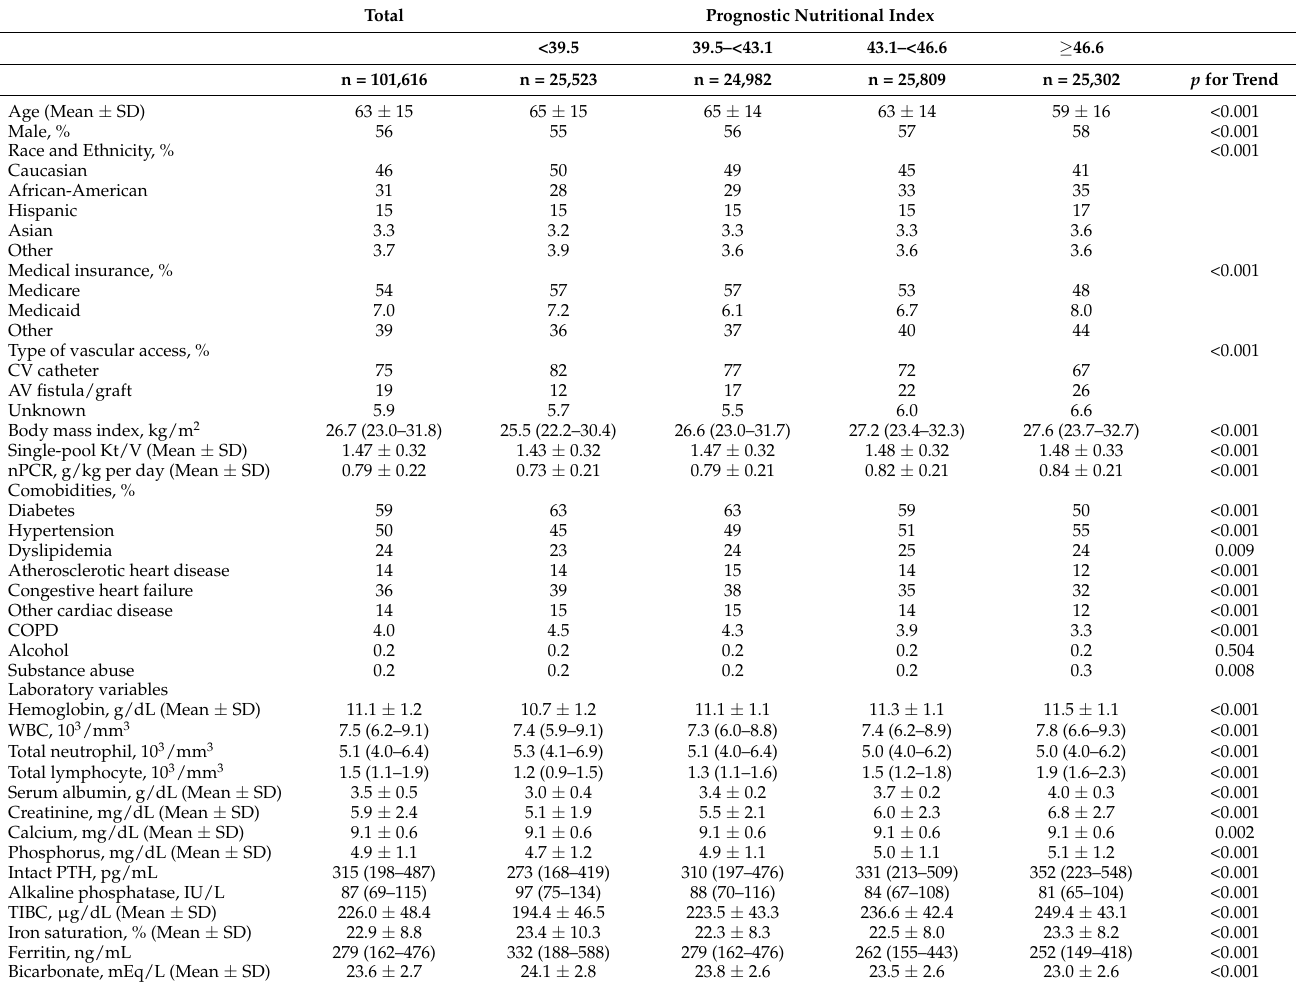
Table 1. Baseline characteristics of 101,616 patients stratified by quartiles of prognostic nutritional